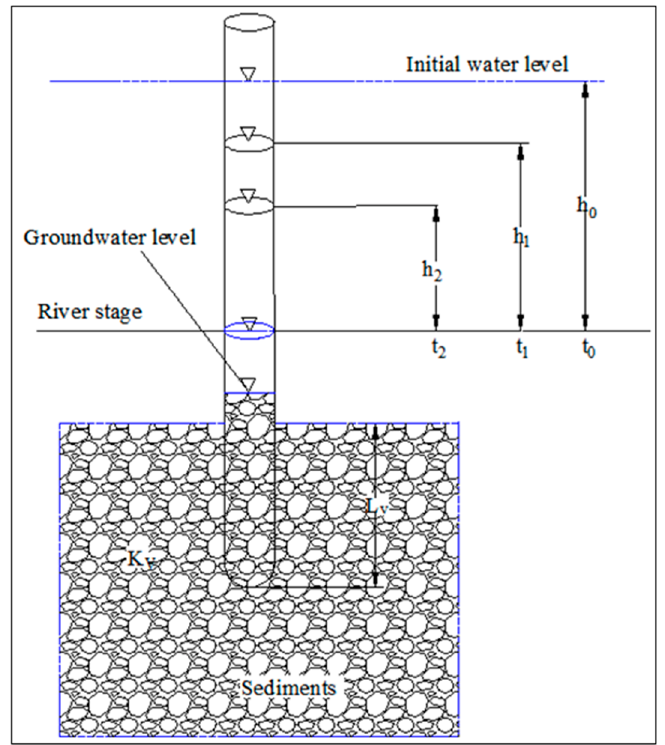
Figure 8. Schematic diagram of the permeability test in streambed sediments.